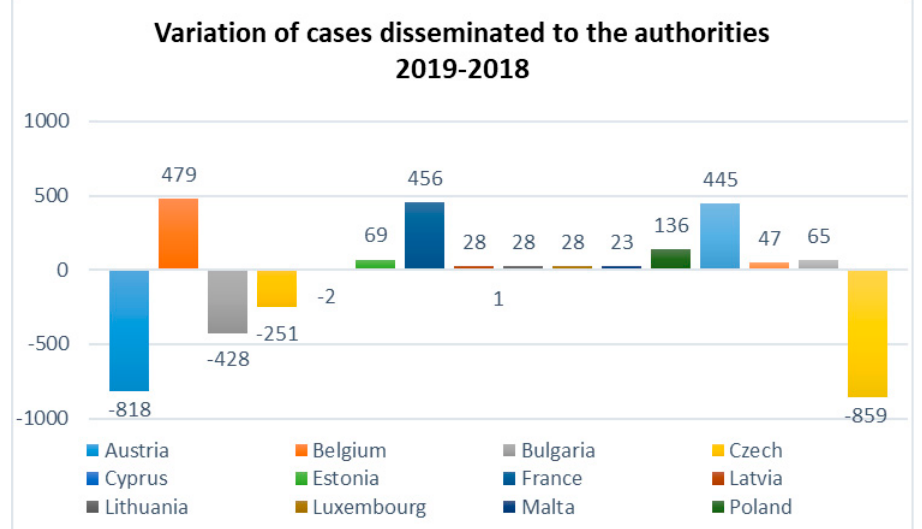
Figure 5. Variation of cases disseminated to the authorities. Source: own processing.